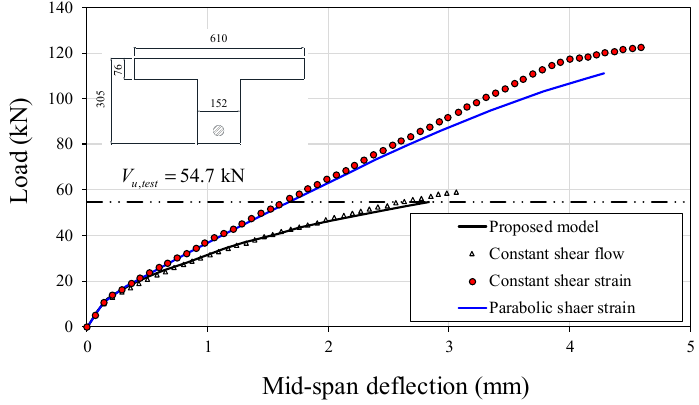
17 of 21 Figure 10. Applied load versus mid-span deflection (OA-3 specimen). 2. T-beam: The advantage that the proposed model possesses is that it describes the shear strain distributions over the cross section very accurately, and, therefore, the state of the section as well. This can best be illustrated by using T-beams, the section of which has larger shear strength than a rectangular section with the same depth and height. For this problem, the predefined shear strain methods, such as constant or parabolic shear strain method, would overestimate the shear strength by drawing more shear stress in the flange area, and keeping the web area stressed in lower intensity. A T-beam (beam no.: T2) was selected from the extensive test conducted by Placas and Regan